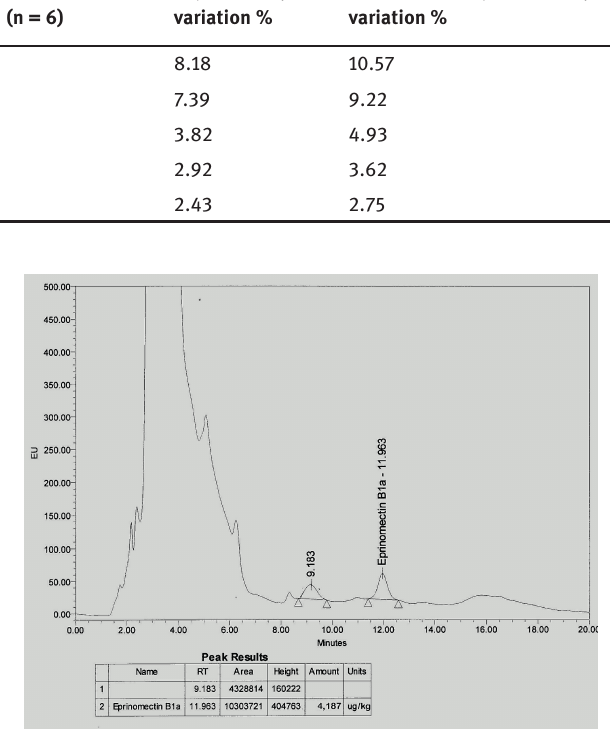
Spiked eprinomectin B fortified samples (μg kg -1